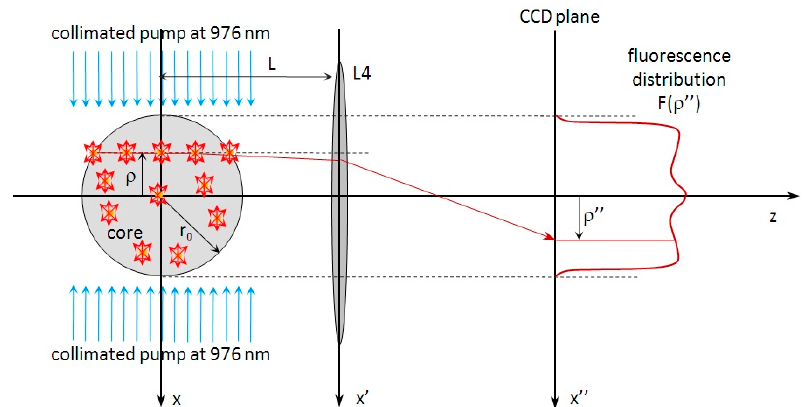
Figure 3. Working principle for the determination of the active dopant distribution f ( r ) in the preform core. An inverse Abel transform was used on the detected projected curve F ( ρ ’’) related to the Yb-ion emission signal.